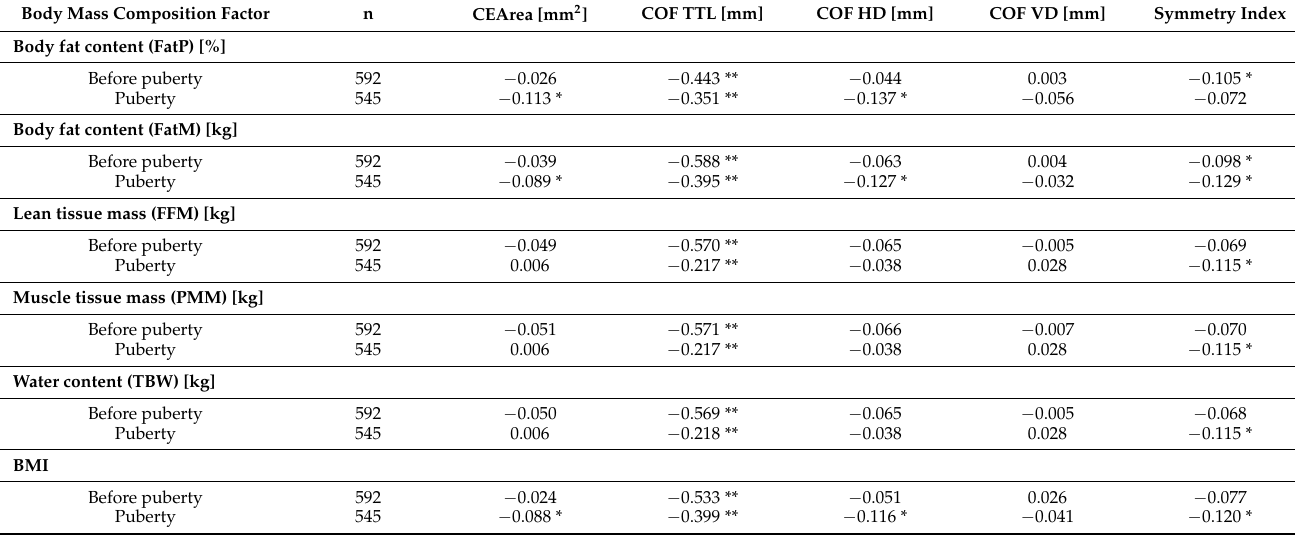
Table 3. Correlation between the composition of body mass, BMI and balance parameters (Rho value). Body Mass Composition Factor